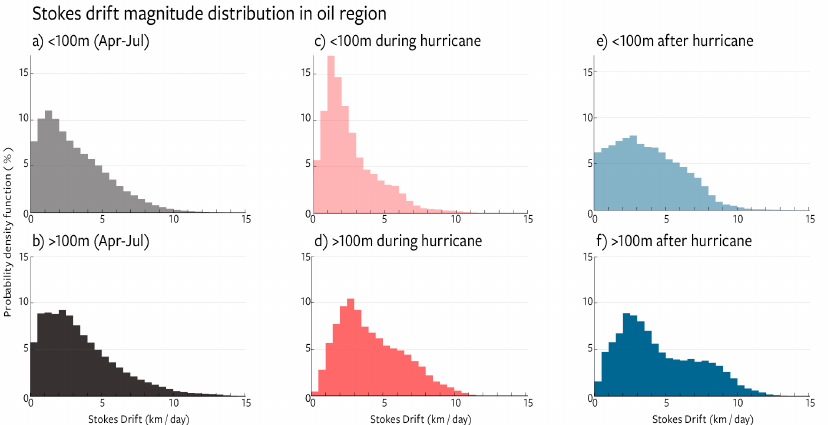
Figure 5. Distribution of modeled (WaveWatch 3) values of Stokes Drift (km / day) in the region near the Deepwater Horizon oil spill with shallow water (shallower than 100 m) data on the top ((panels ( a , c , e )) and deep water (deeper than 100 m) on the bottom (panels ( b , d , f )). Panels ( a , b ) show a long-term average over the period of the oil spill (April–July 2010) for shallow water and deep water, respectively. These distributions peak at slow transport speeds, but the tails are large enough to be of concern for a major oil spill. Panels ( c , d ) show Stokes drift in shallow and deep water, respectively, when the swell from Hurricane Alex was passing through the region, showing much larger storm-induced transport. Panels ( e , f ) show transport in shallow and deep water, respectively, during the week following Hurricane Alex, showing that high rates of transport persist after the passage of the storm system. Stokes Drift was computed based on WaveWatch 3 partitioned data (Wind–Sea, Primary Swell, and Secondary Swell wave height, wave period, and